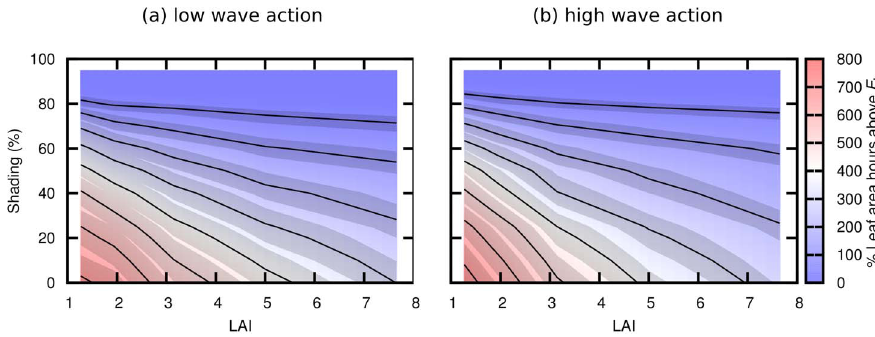
Figure 6. Time accumulated percentage of leaf area irradiated above photosynthetic saturation irradiance. The colour scale shows H A sat , the ‘‘percentage leaf area hours’’ above E k , as a function of LAI and shading. (a) is for upright low wave action canopy structures, (b) is for the average over the high wave energy canopy positions. Contour lines are isoclines based on the mid value of E k equal to 50 m mol quanta m 2 2 s 2 1 while the surrounding greyed region shows the limits for E k of 45 to 55 m mol quanta m 2 2 s 2 1 . The isoclines are located at H A sat of 50, 100, 200, and then steps of 100 up to 800% leaf area